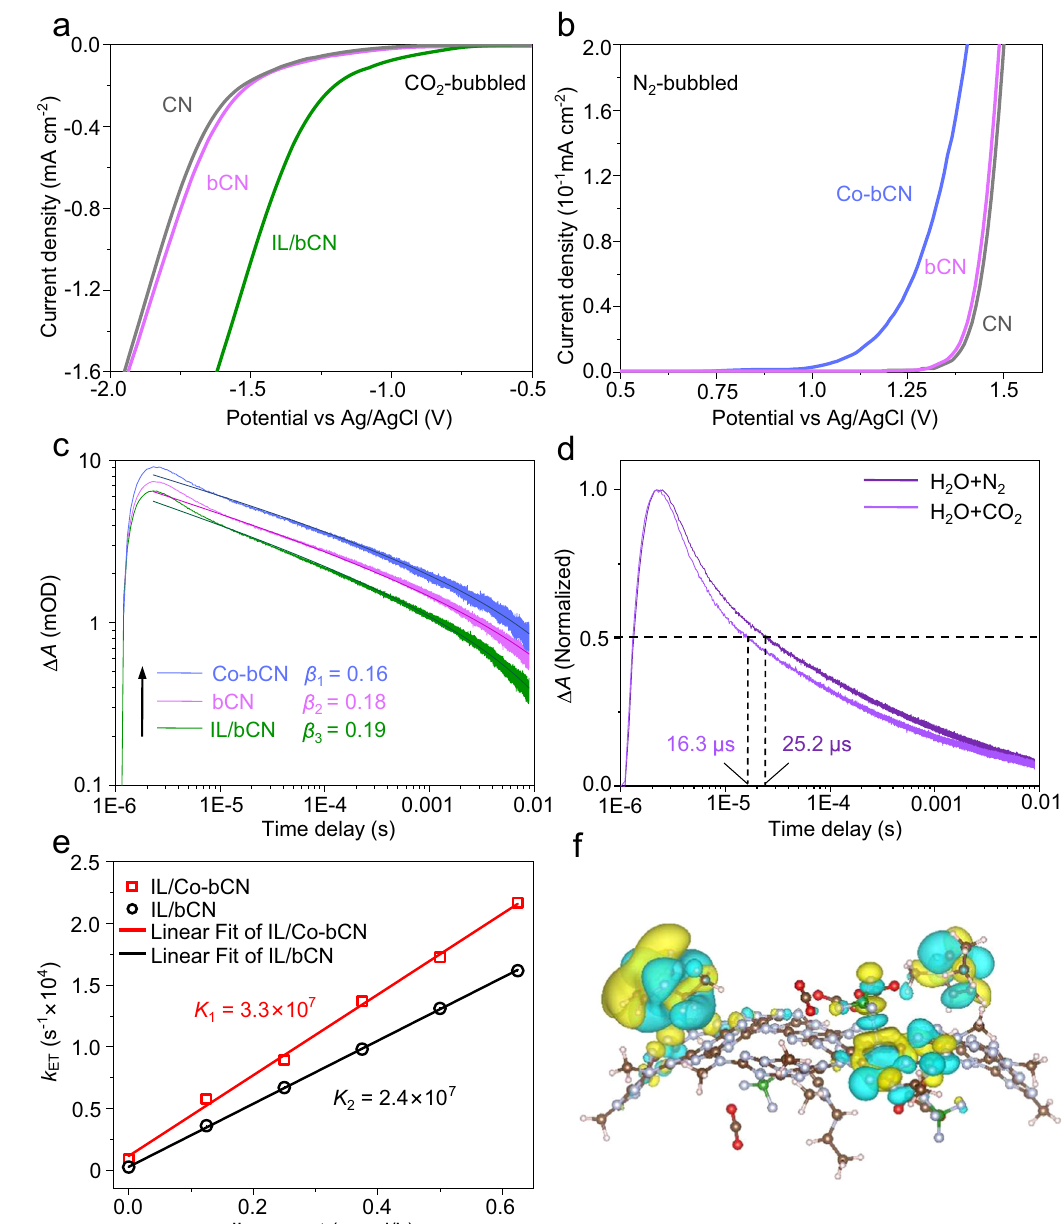
Fig.4|RolesofILandCosingleatoms.a ElectrochemicalreductioncurvesofCN, bCN,andIL/bCNintheCO 2 -bubbledsystem. b Electrochemicaloxidationcurvesof CN,bCN,andCo-bCNintheN 2 -bubbledsystem. c Fittedparameterforanassumed power-lawdecay( I TAS ∝ ( t - t 0 ) − β )ofbCN, Co-bCN, and IL/bCN in the gaseous mixture of N 2 /H 2 O vapor, excited by pulsed 355 nm and monitored at 900 nm. d In situ μ s- TAS spectra over IL/Co-bCN in the gaseous mixture of N 2 /H 2 O vapor or CO 2 /H 2 O